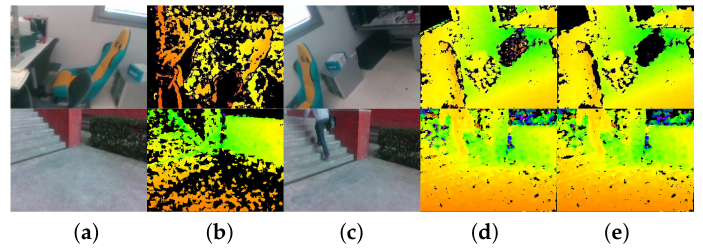
Figure 4. ( a , b ) Original RGB-D perception, depth images are sparse with many mismatched pixels; ( c , d ) RGB-D perception with a dense preset configuration; ( e ) depth images with noise